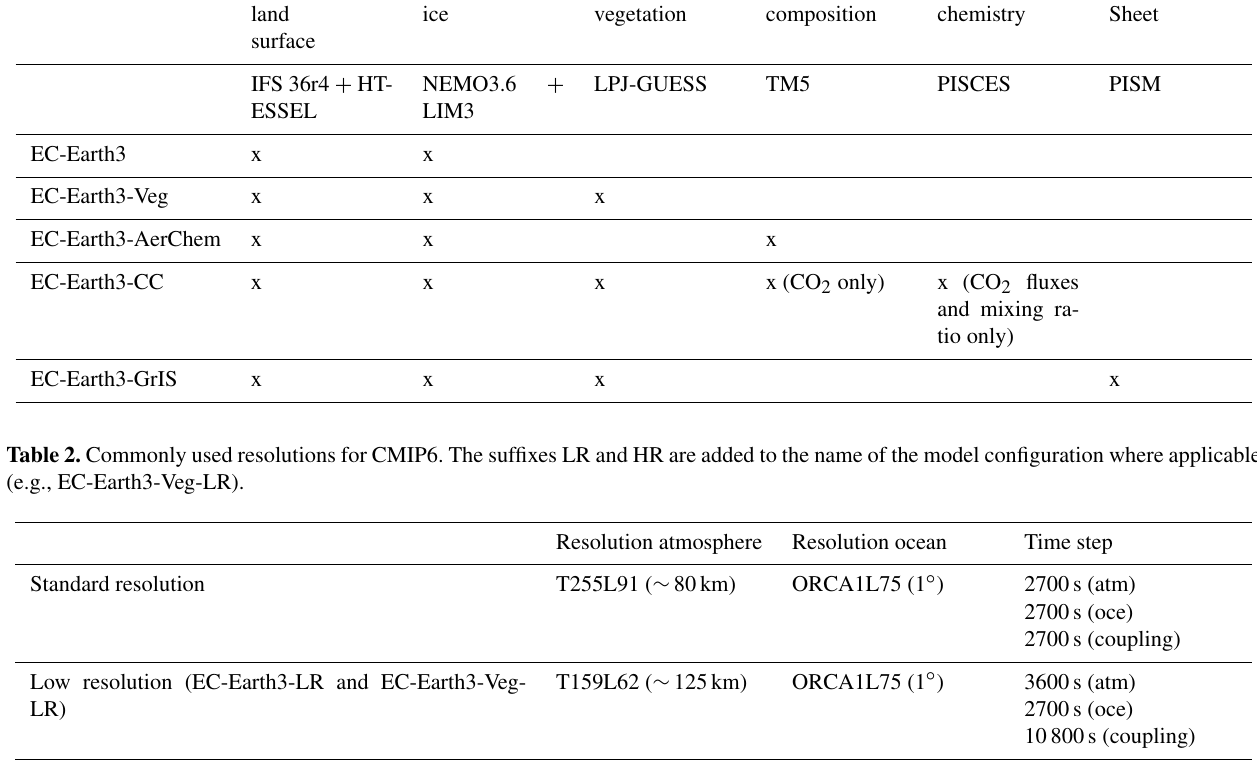
Table 1. Configurations of the EC-Earth model for CMIP6; the name of the configuration is used as source_id in the CMIP6 context. Configuration